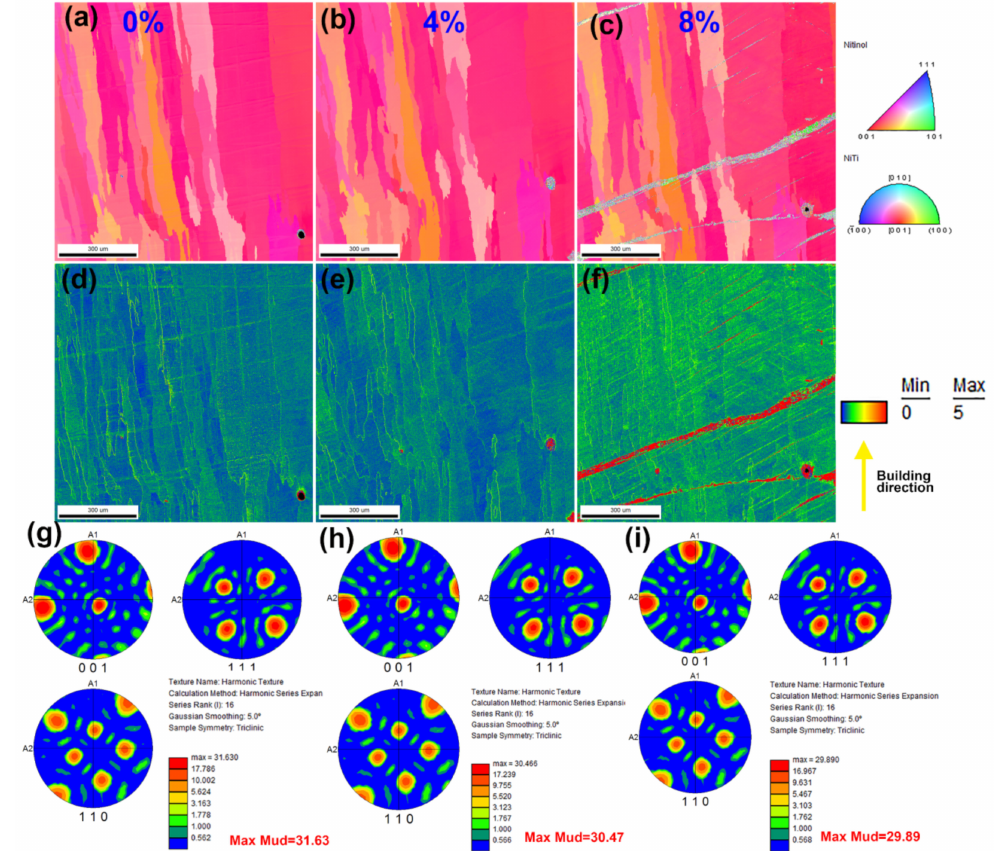
Figure 6. EBSD analysis of different samples: ( a – c ) inverse pole figure orientation contrast maps of the original state, 4% deformation, and 8% deformation samples, respectively; ( d – f ) KAM images of the original state, 4% deformation, and 8% deformation samples, respectively; and ( g – i ) pole figures of the 0% deformation, 4% deformation, and 8% deformation samples in {001}, {110}, and {111},